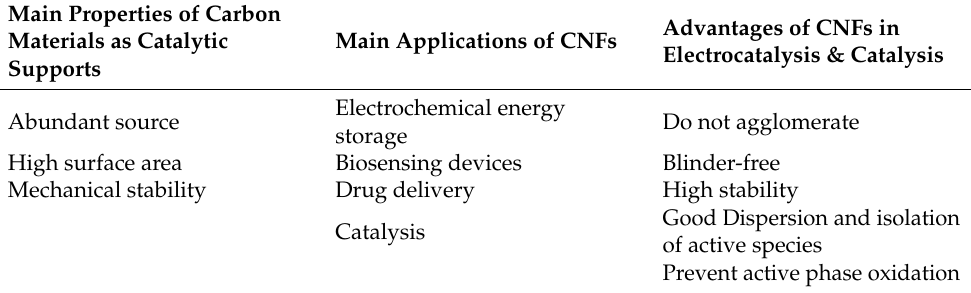
Table 1. Main advantages and applications of